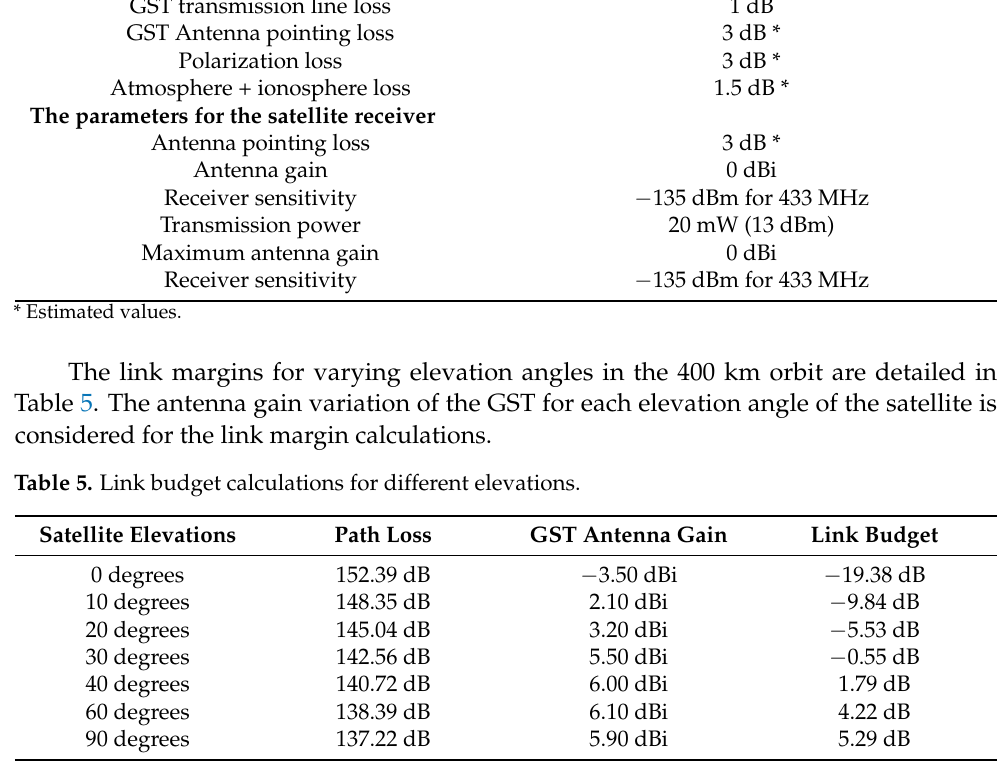
The parameters for the satellite receiver